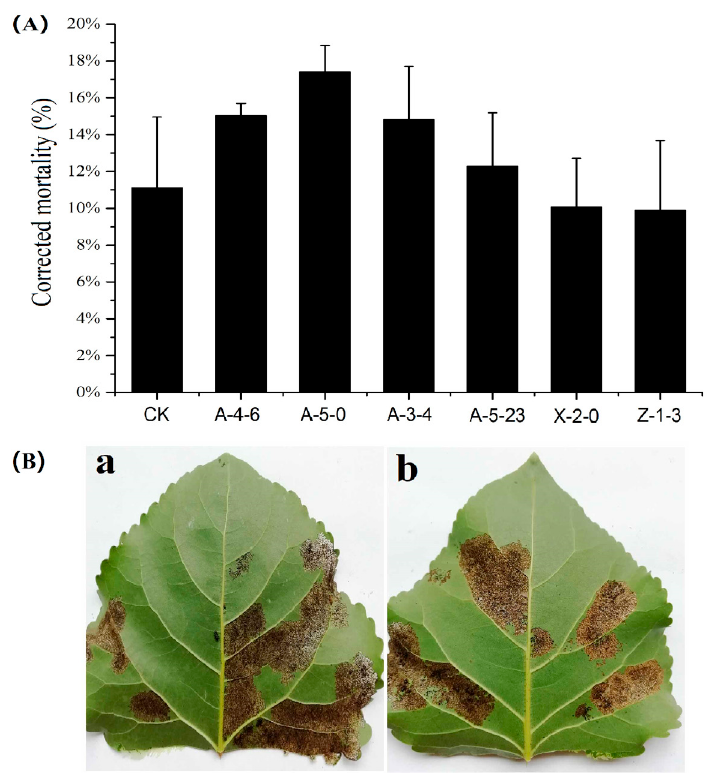
Figure 7. Effects of transgenic poplar on a non-target insect. ( A ) Determination of insecticidal activity of transgenic poplar against P. versicolora . ( B ) Comparison of effects on P. versicolora on day 8 of feeding with CK poplar ( a ) and A-5-0 poplar ( b ).